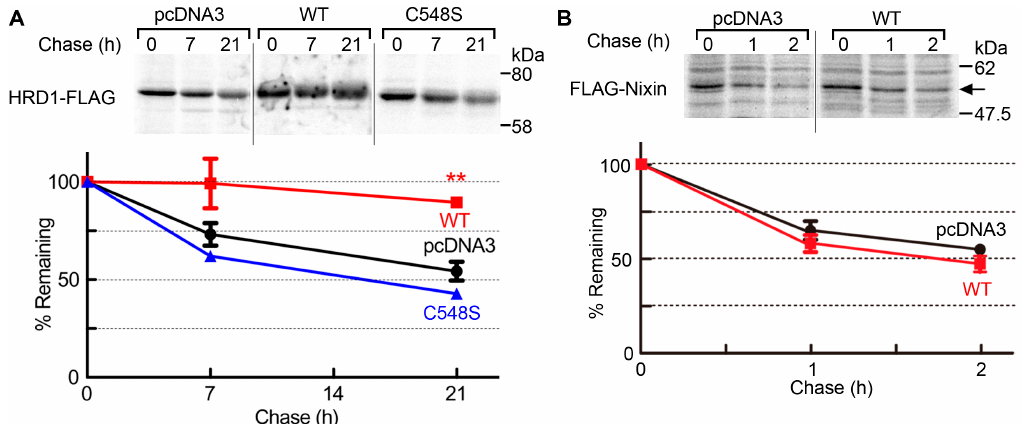
Figure 4. USP19 stabilizes HRD1. HRD1-FLAG ( A ) and FLAG-Nixin ( B ) were transfected into 293T cells along with either a pcDNA3 vector, Myc-USP19 (wild type; WT) or Myc-USP19 C548S (C548S). The cells were pulse labeled with 35 S for 30 min and chased for the indicated periods of time. The cell lysates were immunoprecipitated with an anti-FLAG antibody and then analyzed by SDS-PAGE followed by autoradiography. The data were plotted as a percentage of the remaining proteins relative to time zero from at least three independent experiments (mean ± SEM). ** statistically significant (Student’s t -test, ** p < 0.01).